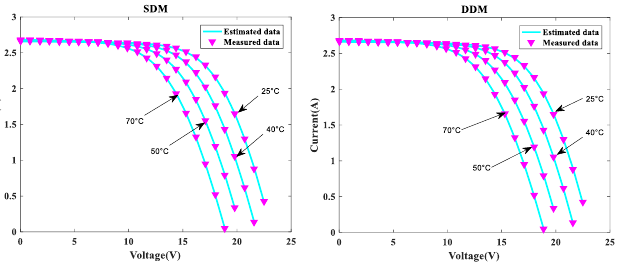
Figure 12. I—V for SM55 at various temperatures.